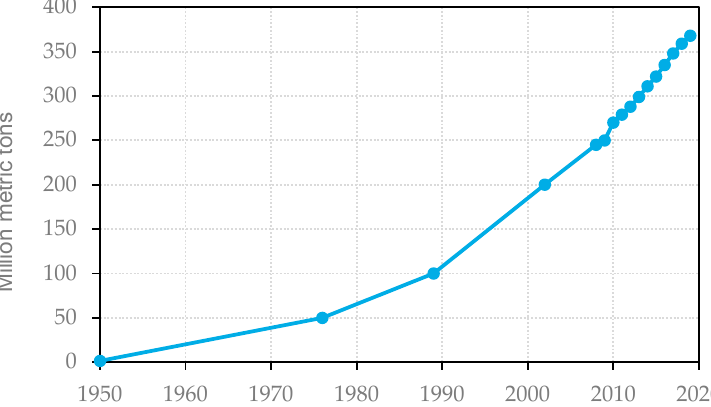
Figure 1. Development of worldwide plastic production from 1950 to 2019 (adapted from [1]).